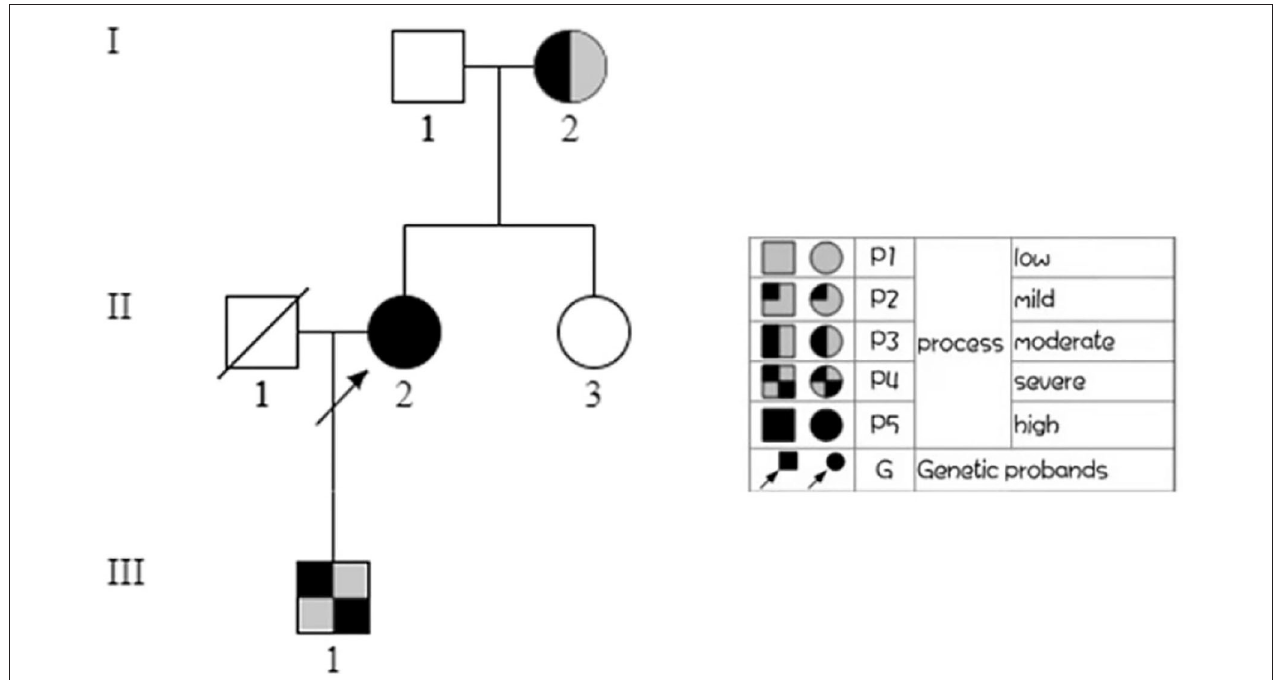
FIGURE 2 | Family tree. In the family tree of this pedigree, the pattern differs as the severity differs. The severity is roughly dependent on the number of MYH9-RD related manifestations. The white pattern indicates physiological condition, while the all black pattern indicates the most